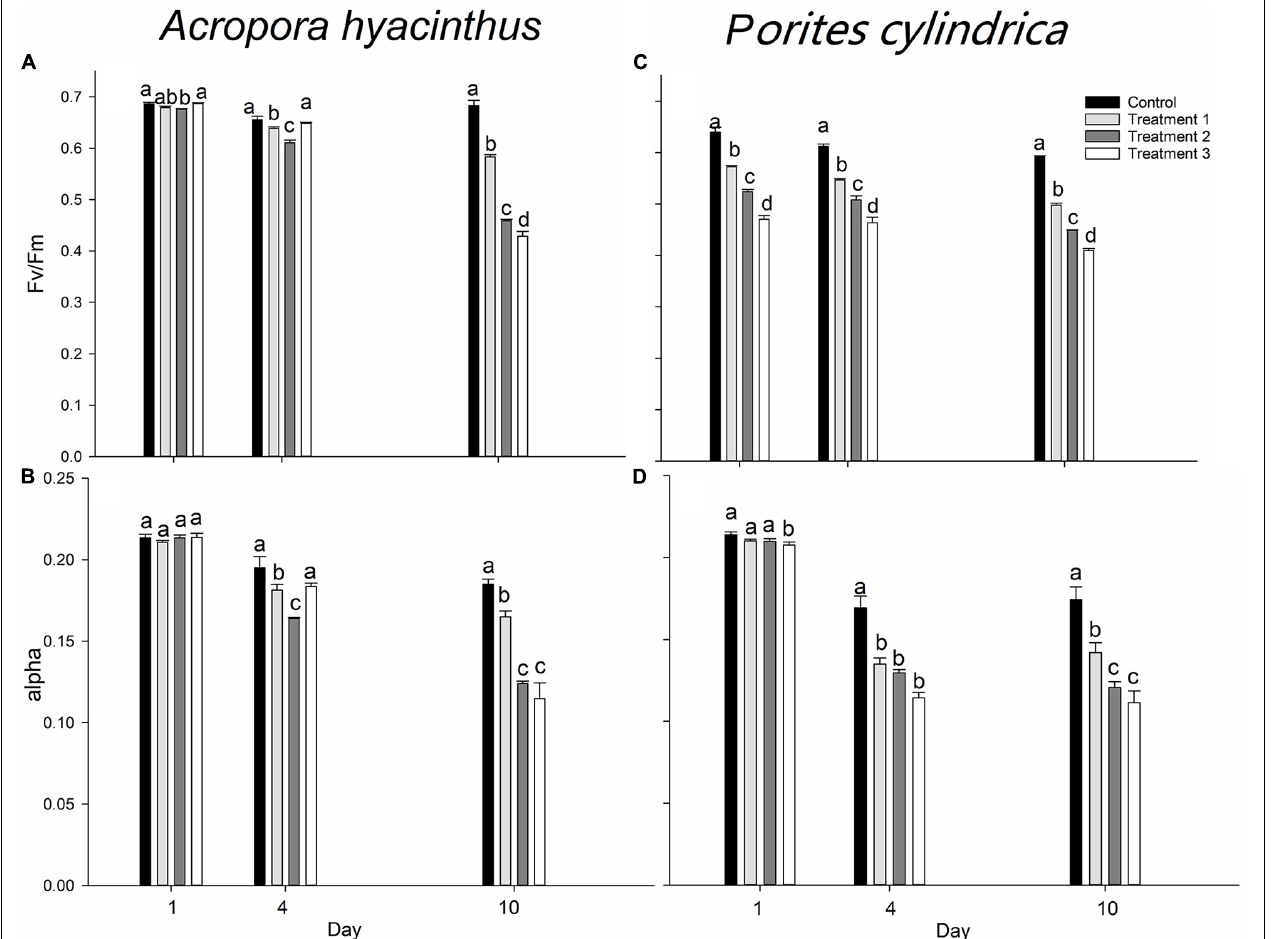
FIGURE 3 | Average (A,C) Fv/Fm and (B,D) alpha in the control group and three treatment groups (1 = touching, 2 = touching, and ammonia nitrogen enrichment, 3 = touching, ammonia nitrogen enrichment, and sediment cover) for A. hyacinthus and P. cylindrica on days 1, 4, and 10. Each bar represents the mean of three samples ± SD (standard deviation). The data with different letters above bars are significantly different on the same day at P < 0.05